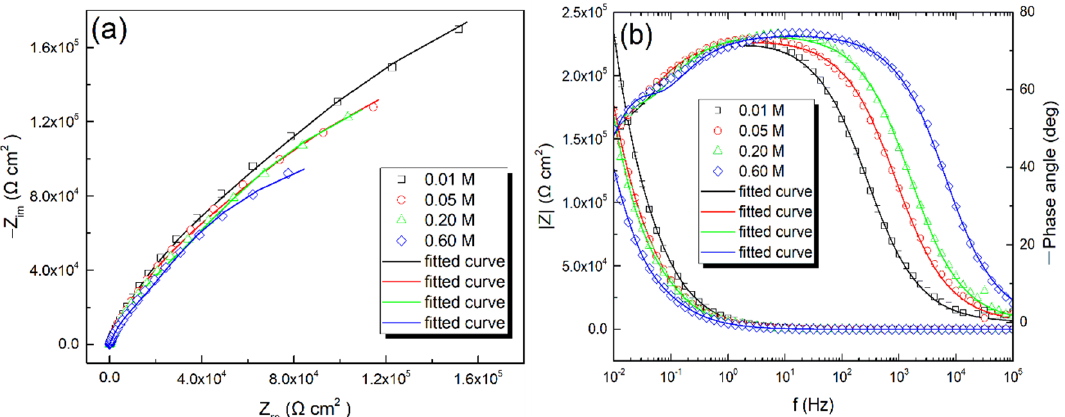
Figure 5. Typical electrochemical impedance spectra (EIS) ( a ) Nyquist diagram, and ( b ) Bode diagram for galena in NaCl solutions of different concentrations at pH 6.7.